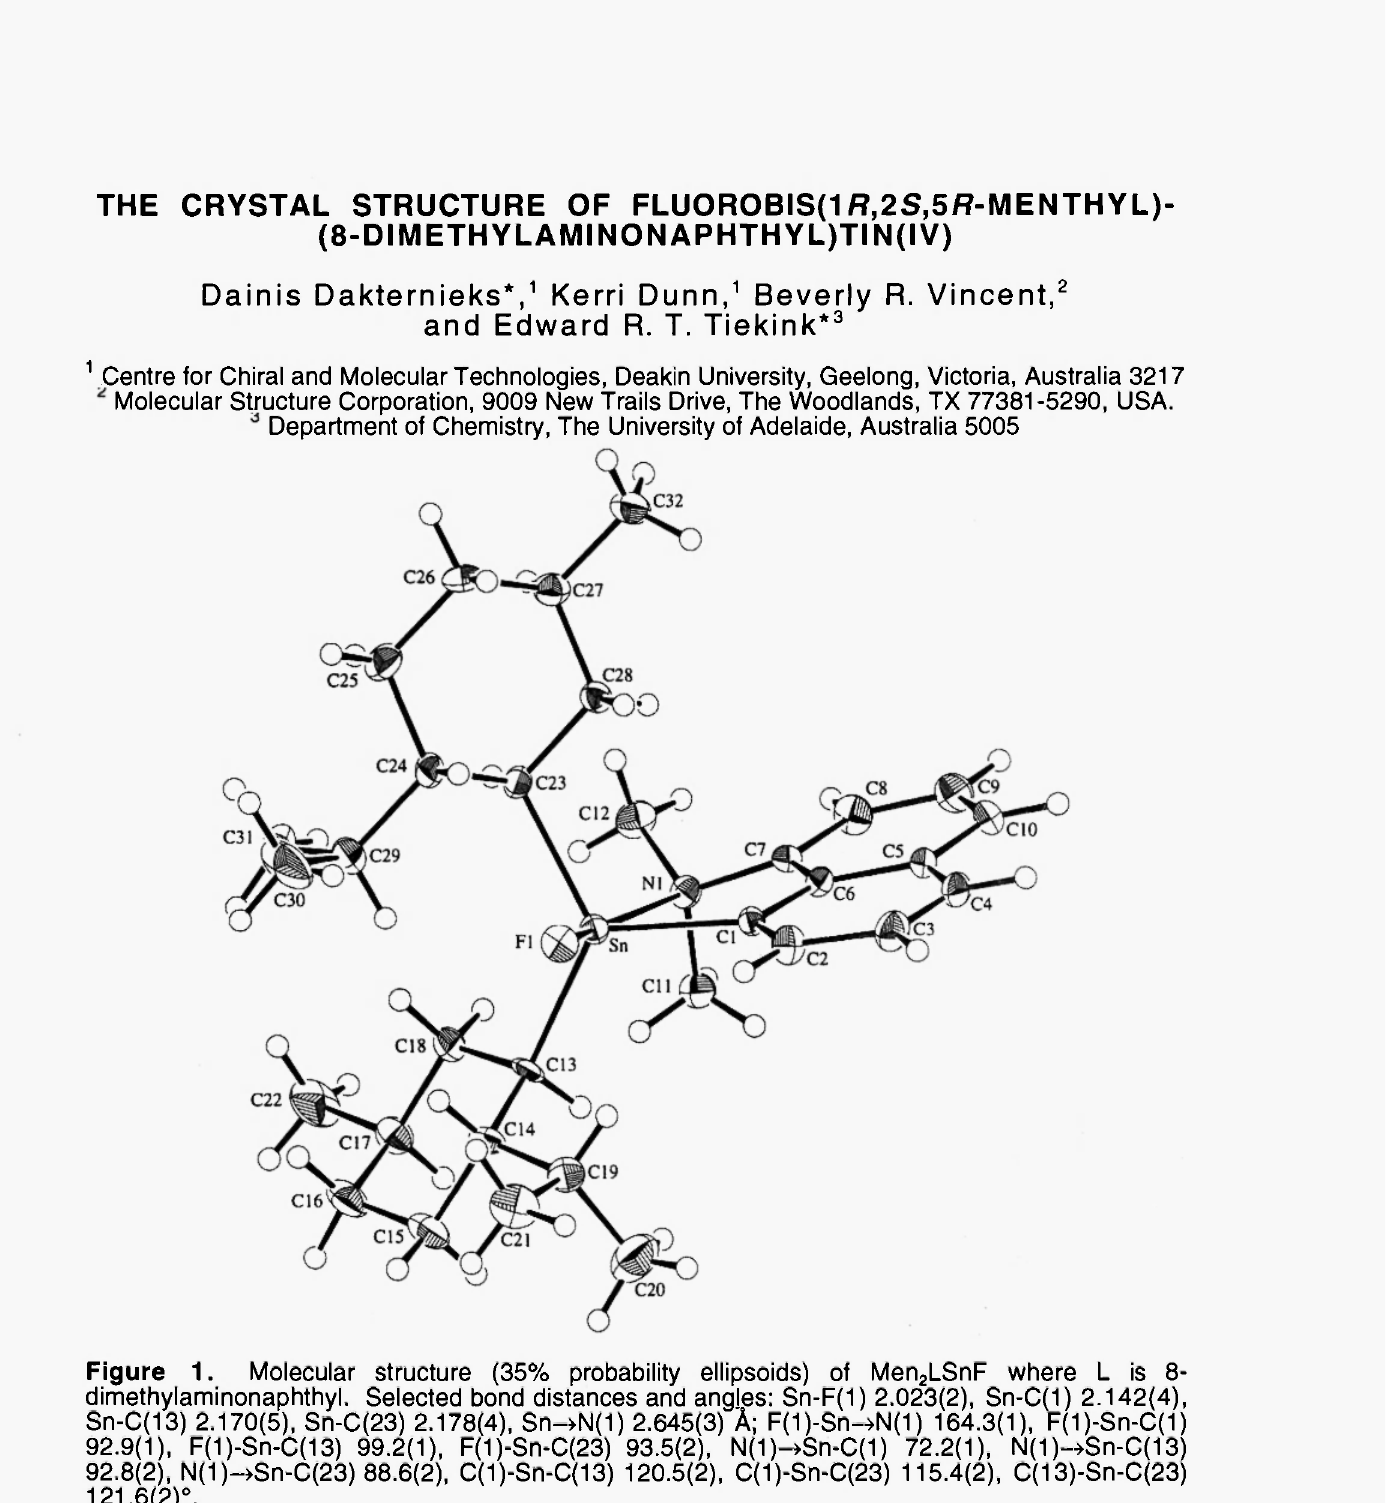
Figure 1. Molecular structure (35% probability ellipsoids) of Men 2 LSnF where L is 8- dimethylaminonaphthyl. Selected bond distances and angles: Sn-F(1) 2.023(2), Sn-C(1) 2.142(4), Sn-C(13) 2.170(5), Sn-C(23) 2.178(4), Sn-»N(1) 2.645(3) Ä; F(1)-Sn-»N(1) 164.3(1), F(1)-Sn-C(1) 92.9(1), F(1)-Sn-C(13) 99.2(1), F(1)-Sn-C(23) 93.5(2), N(1)-»Sn-C(1) 72.2(1), N(1)-*Sn-C(13) 92.8(2), N(1)-»Sn-C(23) 88.6(2), C(1)-Sn-C(13) 120.5(2), C(1)-Sn-C(23) 115.4(2), C(13)-Sn-C(23) 121.6(2)°.